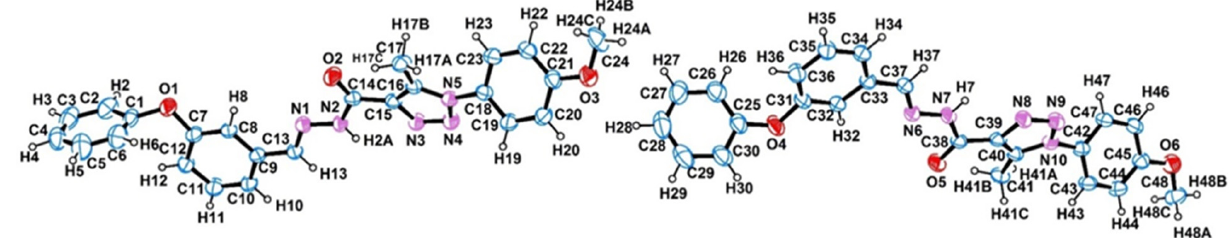
Figure 1. The two molecules of the asymmetric unit of 2 with the atom-labeling scheme. Displacement ellipsoids are drawn at the 50% probability level.